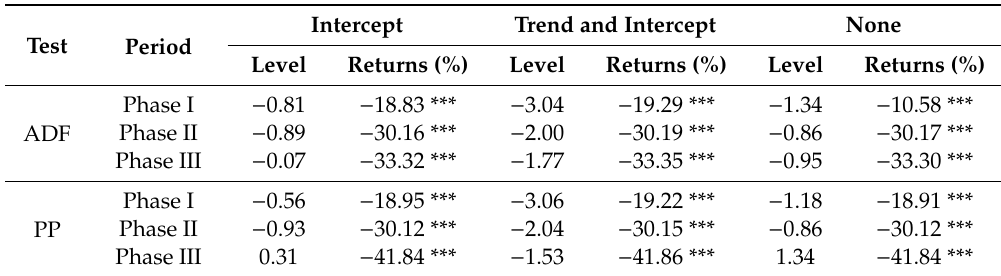
Table 4. The results of the unit root test.